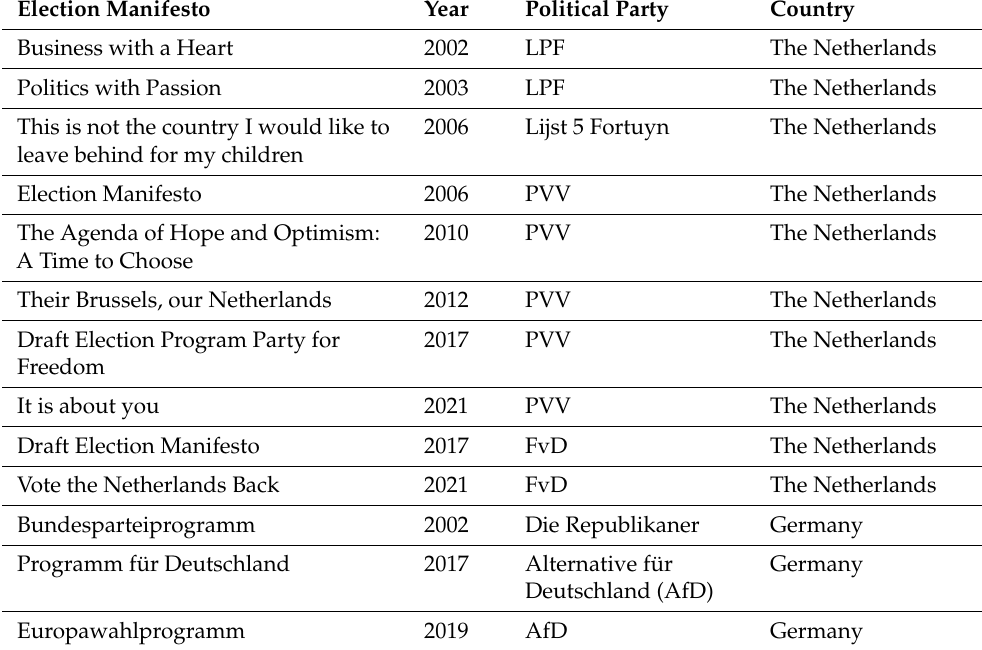
Table 1. Overview of Dutch and German party manifestos